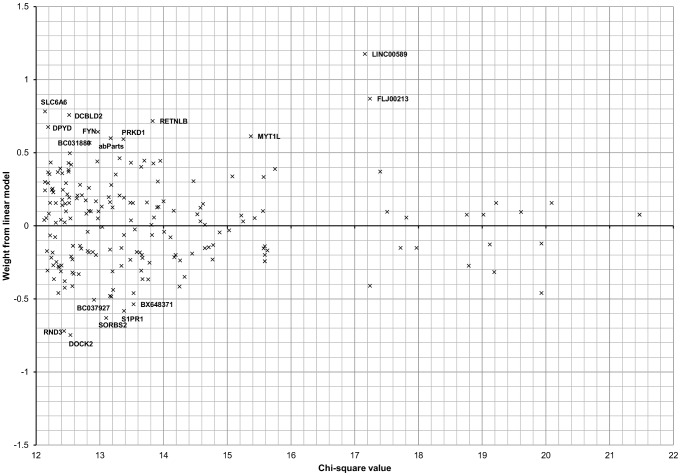
Relationship between weights under a linear classifier and chi-square values used in feature selection.SVM models were constructed on 542 study samples with genotype data for a subset of 200 SNPs chosen based on ER+/− association, determined from the chi-square statistic. SNP feature weights were obtained from the linear SVM model and used as an indicator of the importance of each feature for classification; SNPs with the largest absolute weight values are the most important for classification. Chi-square values used in feature selection and SVM classifier weight values are uncorrelated; Pearson’s correlation coefficient r = −0.026. SNPs with absolute weight values > 0.5 are annotated with the name of the gene in which they reside or are in closest proximity to.